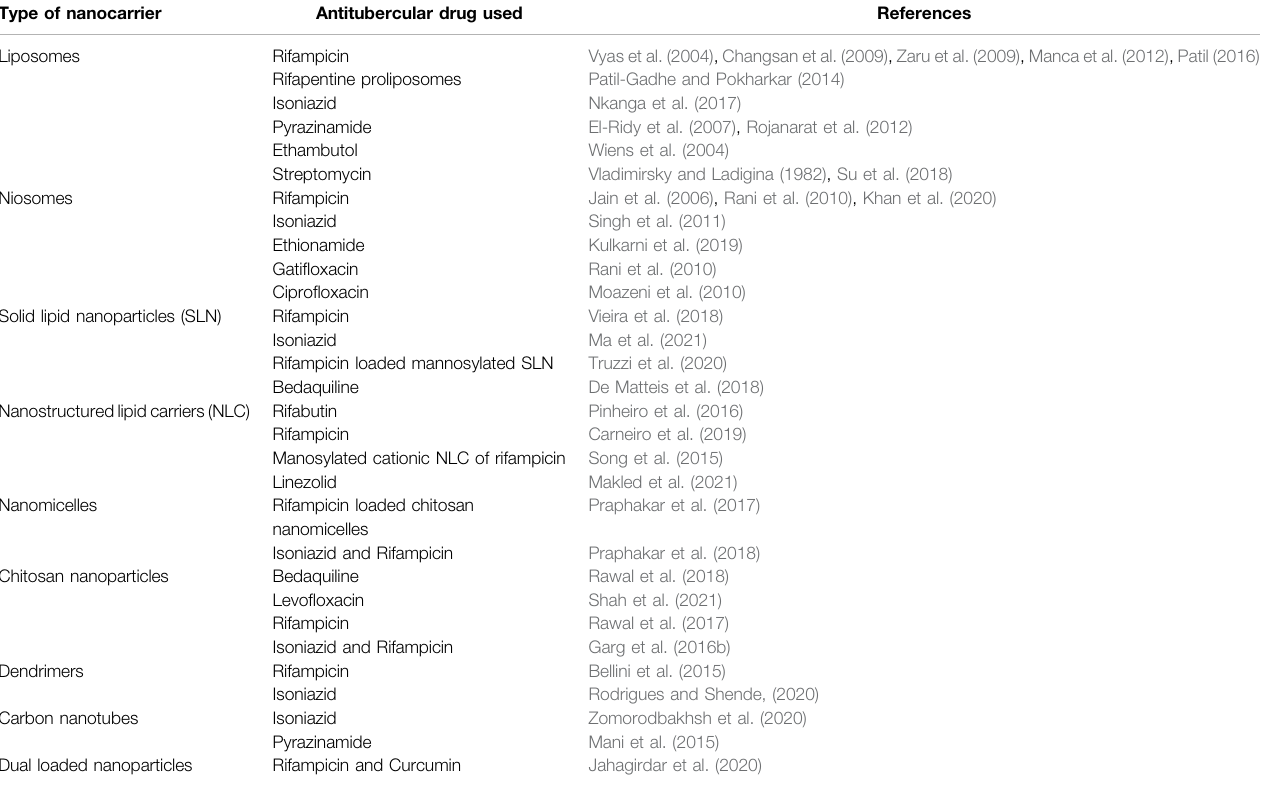
TABLE 1 | List of nanacarriers useful in tuberculosis